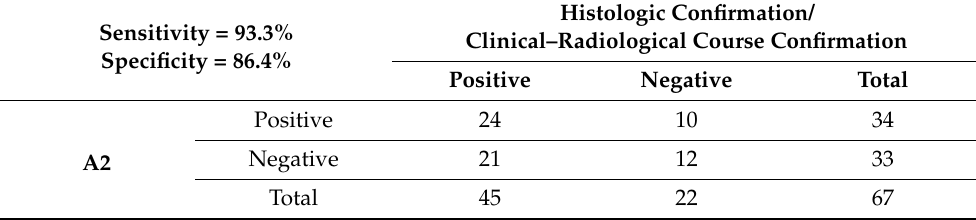
Table 7. Sensitivity and specificity of 68 Ga-DOTATOC-PET/CT A2 with histologic and clinical– radiological course confirmation.